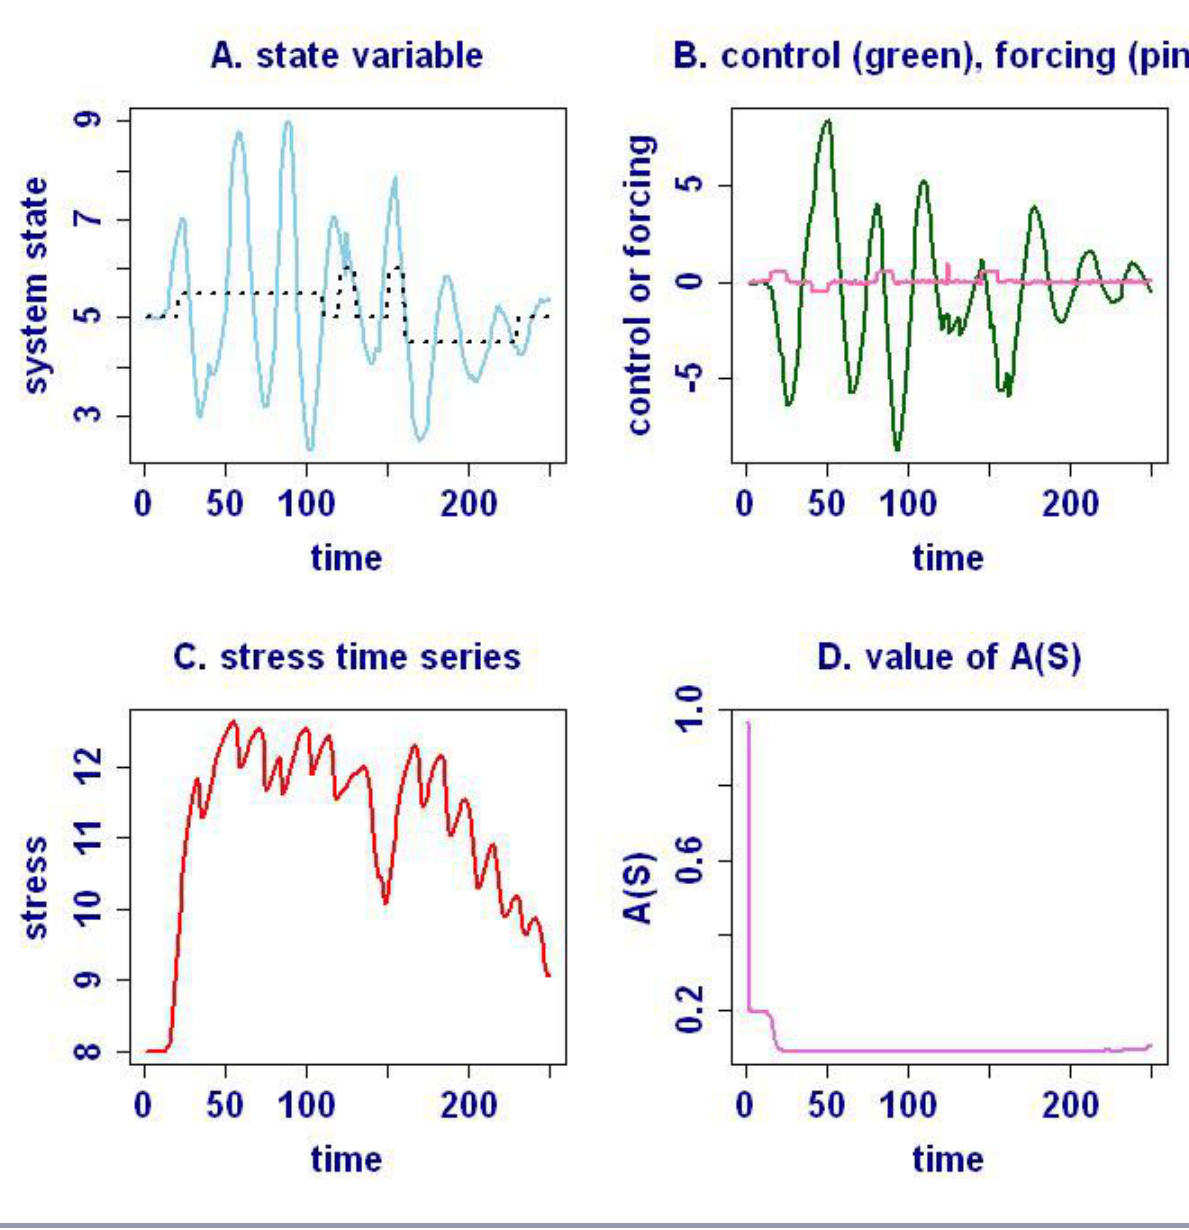
Fig. 3. Example of dynamics in the rigidity trap (S* = 8). (A) State variable y (light blue) and target y* (dark blue dash). Standard deviation of the distance of y from the target is 1.41. (B) Control magnitude u and disturbance n. (C) Stress S. (D) Adaptive capacity